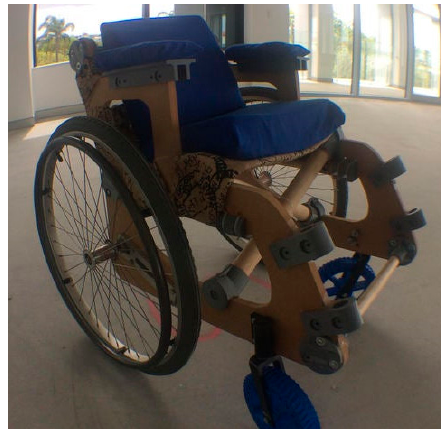
Figure 4. An open source wheelchair called the HU-GO.